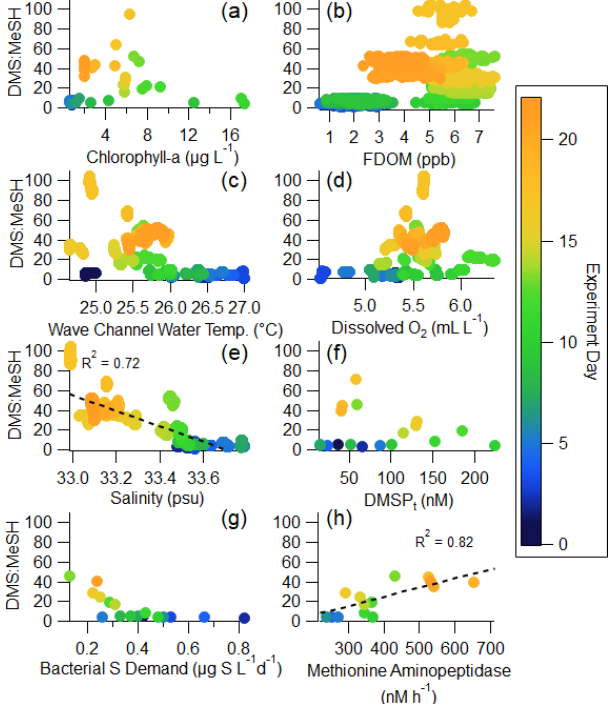
Figure 5. Regressions of DMS:MeSH versus waterside variables measured in the wave channel: (a) chlorophyll a , (b) FDOM, (c) wave channel water temperature, (d) dissolved oxygen, (e) salin- ity, (f) DMSP t , (g) bacterial sulfur demand (using a cellular C:S ratio in bacteria of 248; Cuhel et al., 1982), and (h) methionine aminopeptidase activity. The color of the marker indicates the day of the bloom. Panel (a) uses 2h averages; (b) , (c) , (d) , and (e) use minute averages; and (f) , (g) , and (h) use daily